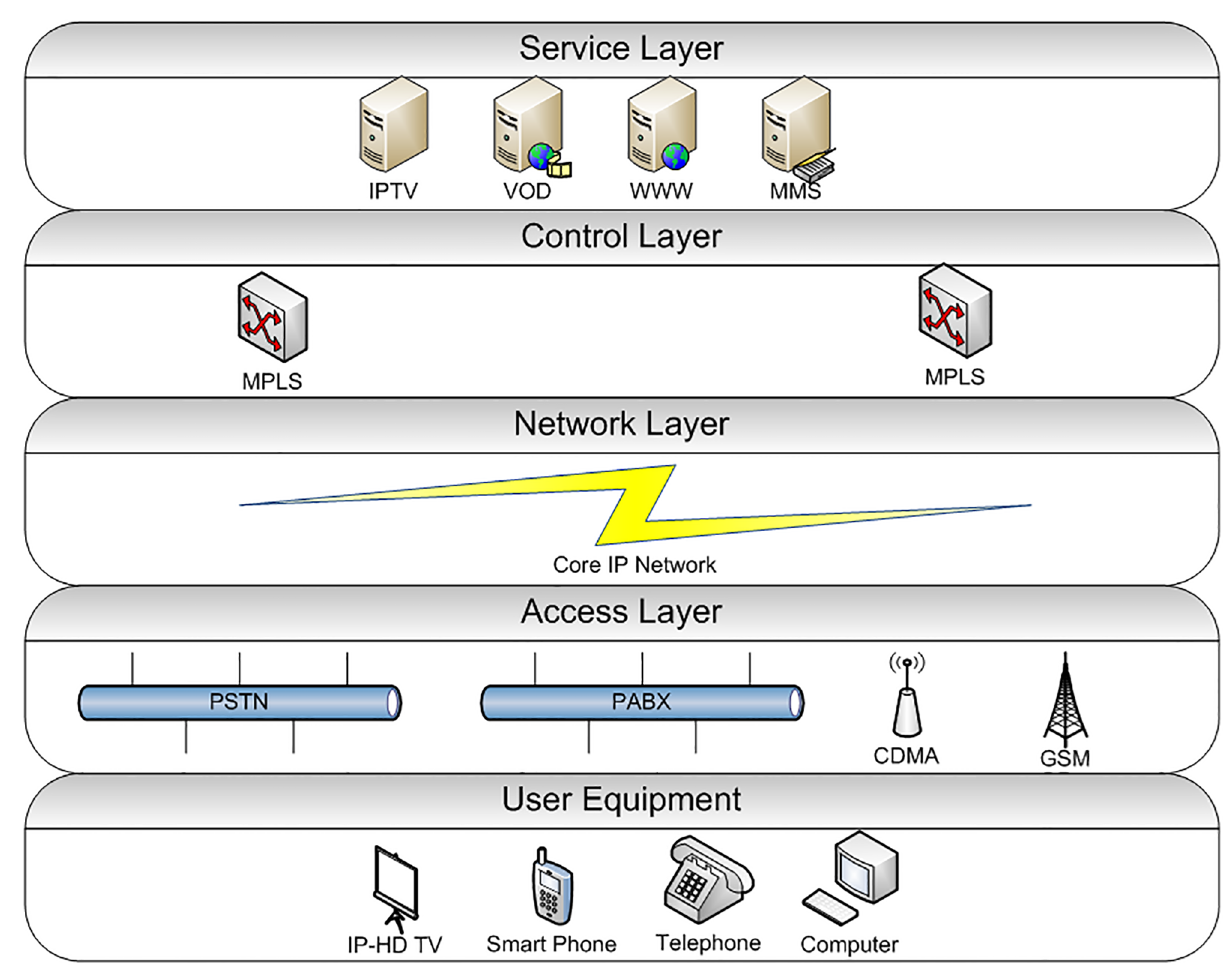
Fig 1. Next-generation network